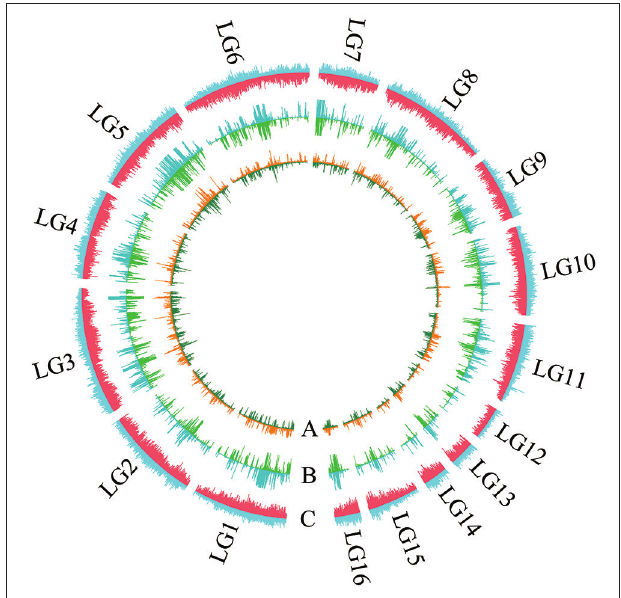
FIGURE 2 | Landscape of the genome variation in “Baizhima” and “Mishuozhima. ” Distribution of (A) SNPs, (B) Indels, and (C) Transposons in the genomes. The upside and downside of each circle show genome variations of “Baizhima” and “Mishuozhima,” respectively. The linkage groups of sesame genome are indicated.